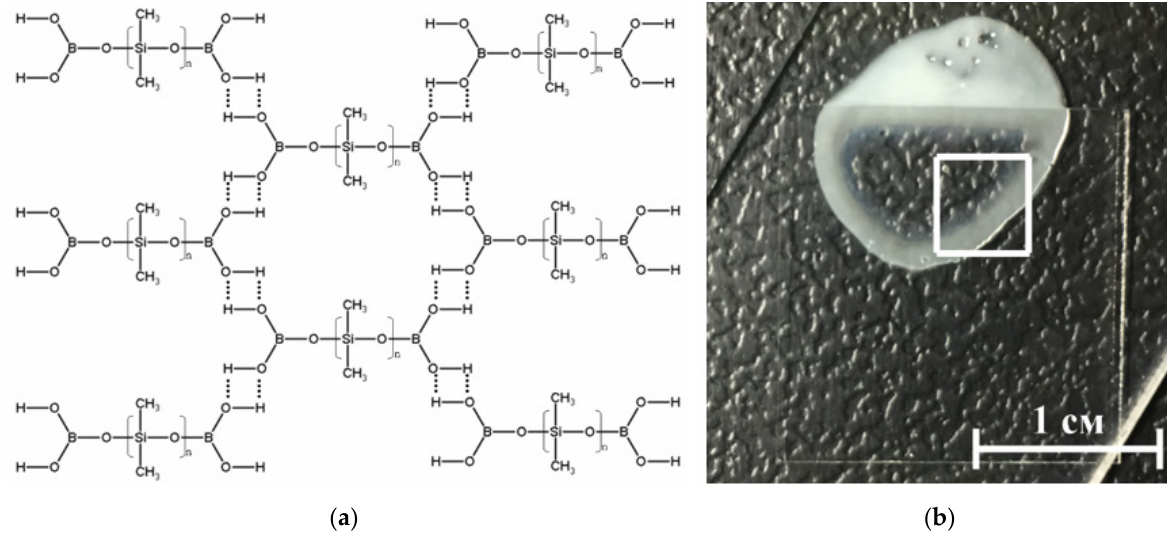
Figure 3. ( a ) Schematic representation of the structure of the borosiloxane (BS). BS molecules linked through hydrogen bonds; ( b ) Photography of composite material, part of the sample is under the cover glass.